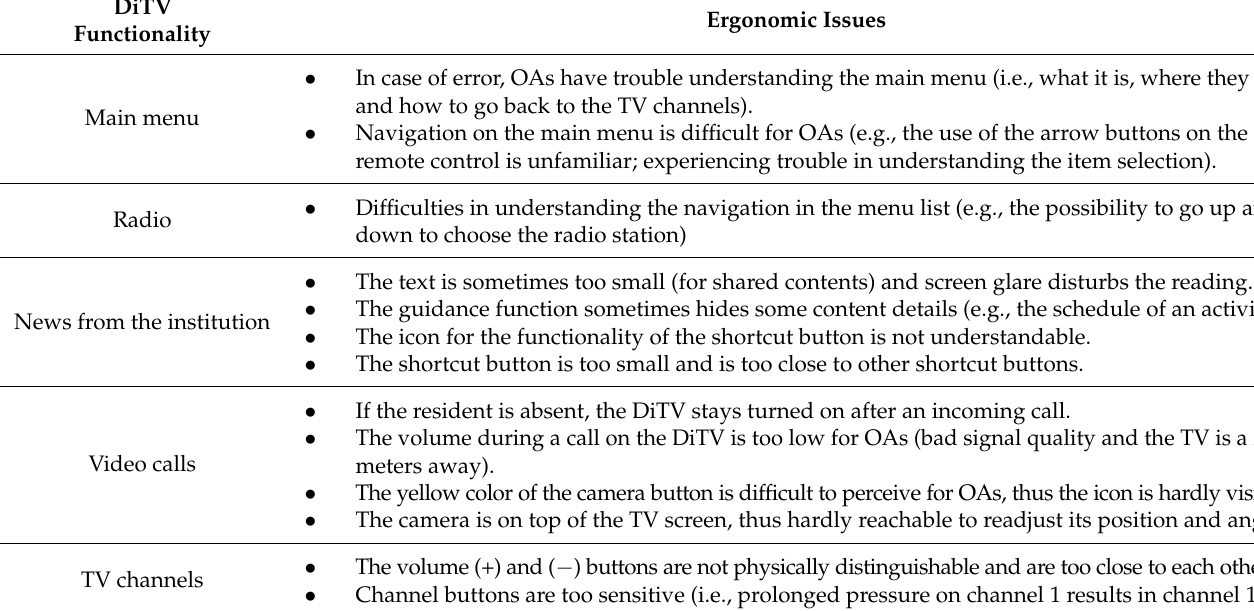
Table 4. Summary of the ergonomic issues reported by residents or observed by researchers during the